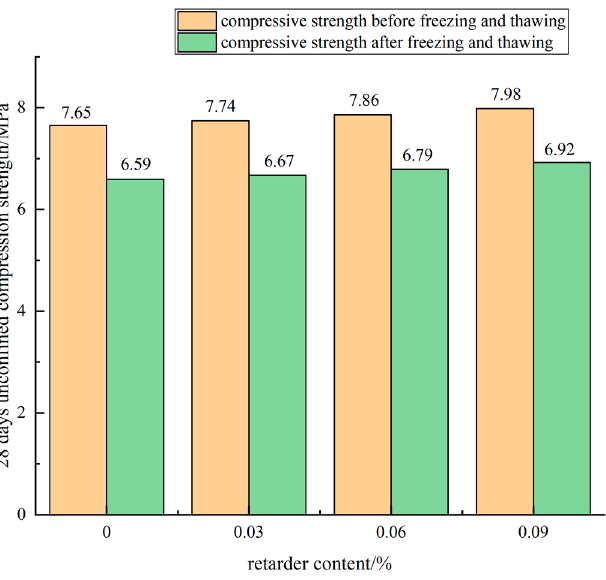
Figure 19. Influence curve of retarder content on BDR.